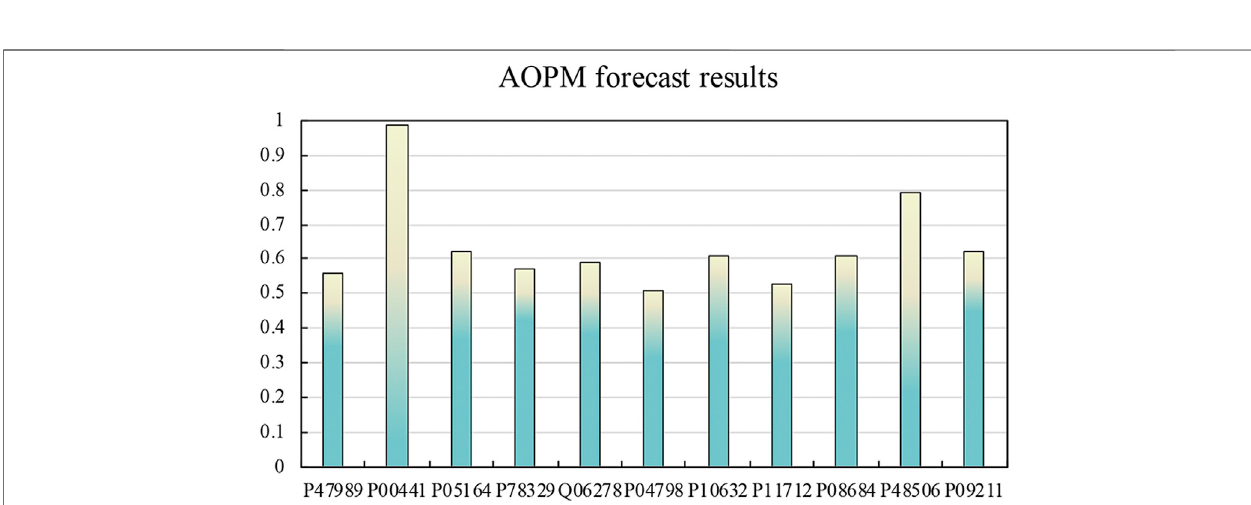
FIGURE 3 | The classi fi cation results of different classi fi ers on the train dataset. The SP, ACC, MCC, and AUC of random forest were much higher than other traditional classi fi ers, which were 0.960, 0.898, 0.802, and 0.964, respectively. Compared with the Bagging classi fi er with the highest SN value, the SN value reaches 0.836, which was nearly lower than the highest value of 0.027.